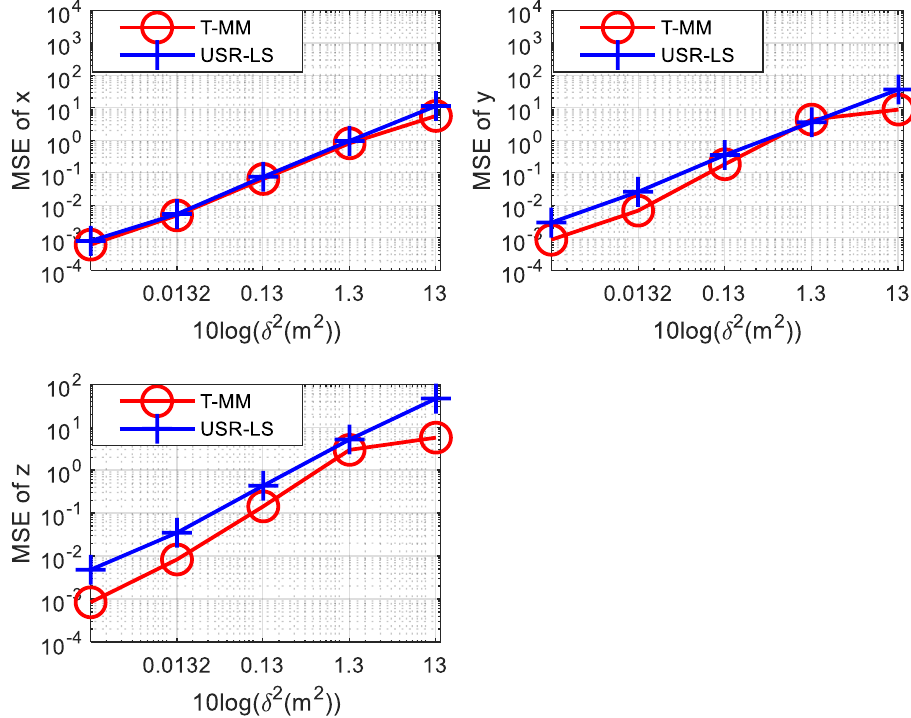
Figure 7. Comparison between the proposed T-MM scheme and conventional USR-LS localization scheme in terms of the MSE under different 𝛿 2 values in 3D scenario.